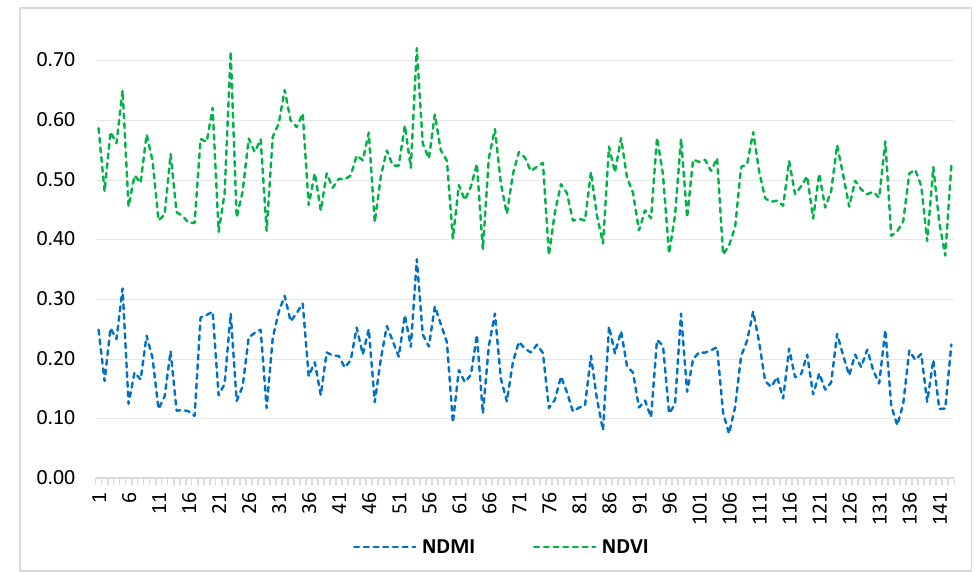
Figure 10. Temporal Variation of the NDVI and NDMI Value Based Vegetation Density Classes of 143 Center pivot wheat Field in 2021.